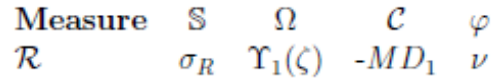
Figure A4. Risk-adjusted performance metrics.